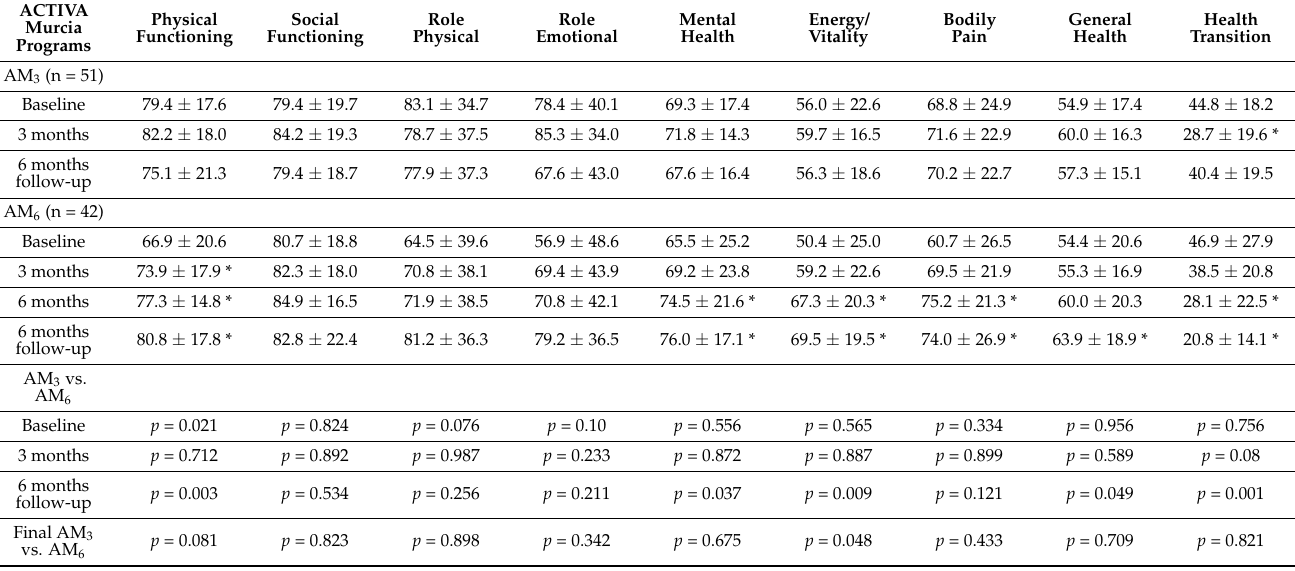
Table 2. Differences in HRQL between the two community-based exercise programs.